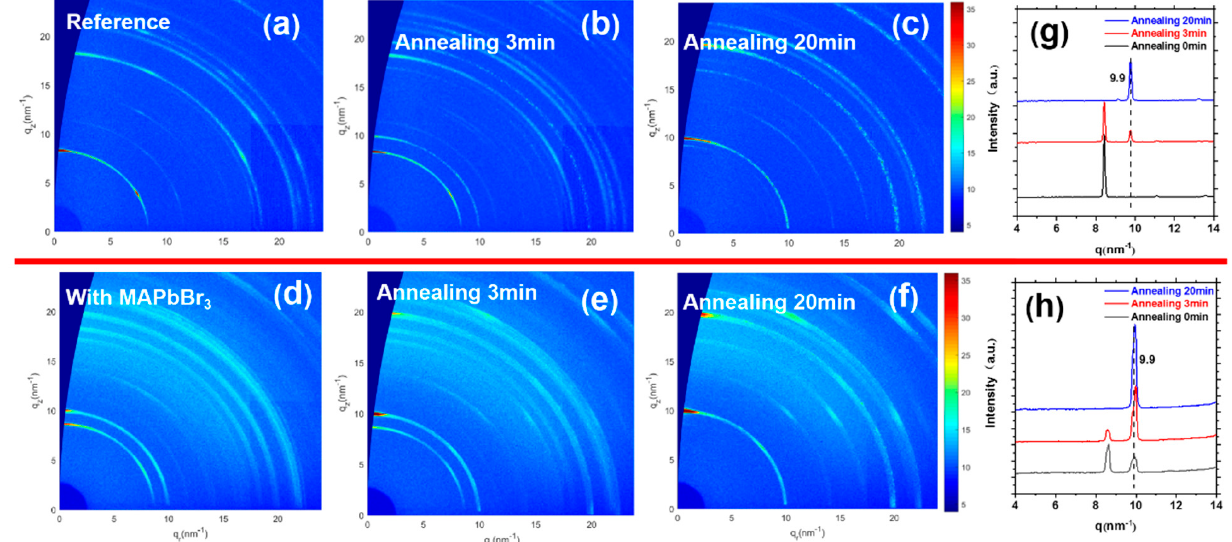
Figure 3. The 2D GIWAXS patterns taken at different time points during annealing for the undoped film in ( a – c ) and for the MAPbBr 3 -doped perovskite film in ( d – f ), respectively. The derived 1D XRD spectra for the undoped film in ( g ) and for the MAPbBr 3 -doped perovskite film in ( h ), respectively.